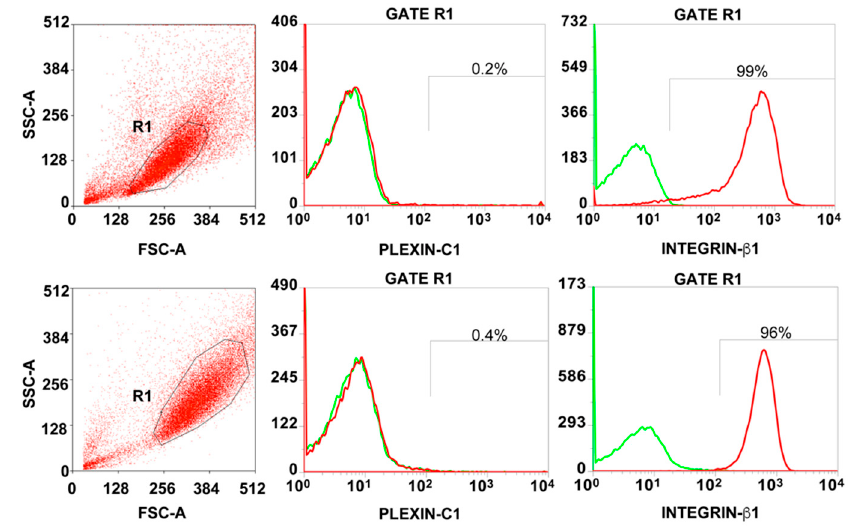
Figure 3. Expression of SEMA7A (Semaphorin7A) receptors on Glioma Stem Cells (GSC) . Representative flow cytometry analysis showing the level of Plexin C1 and Integrin β 1 on the surface of two GSC cell populations. The percentage of positive cells was calculated within the R1-Gate, representing the GSC population based on forward and side scatter (FSC/SSC) parameters. Histograms overlays show isotype control staining profile (green histograms) versus specific antibody staining profile (red histograms).